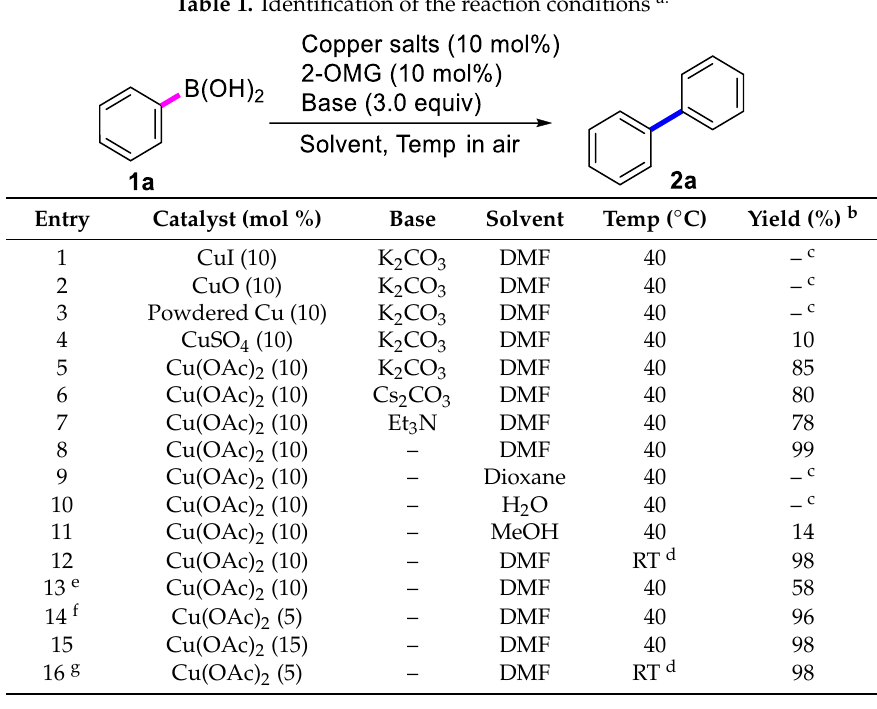
Table 1. Identification of the reaction conditions a.